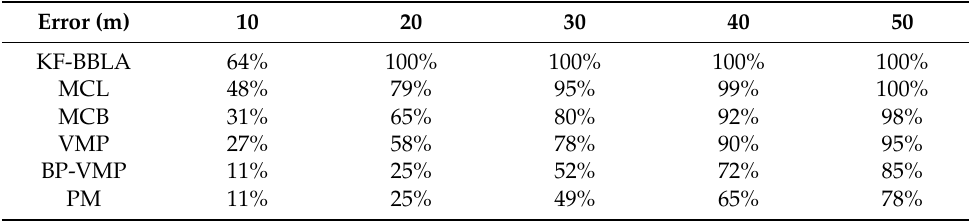
Figure 7. Localization techniques’ accuracy. Table 3. Simulation